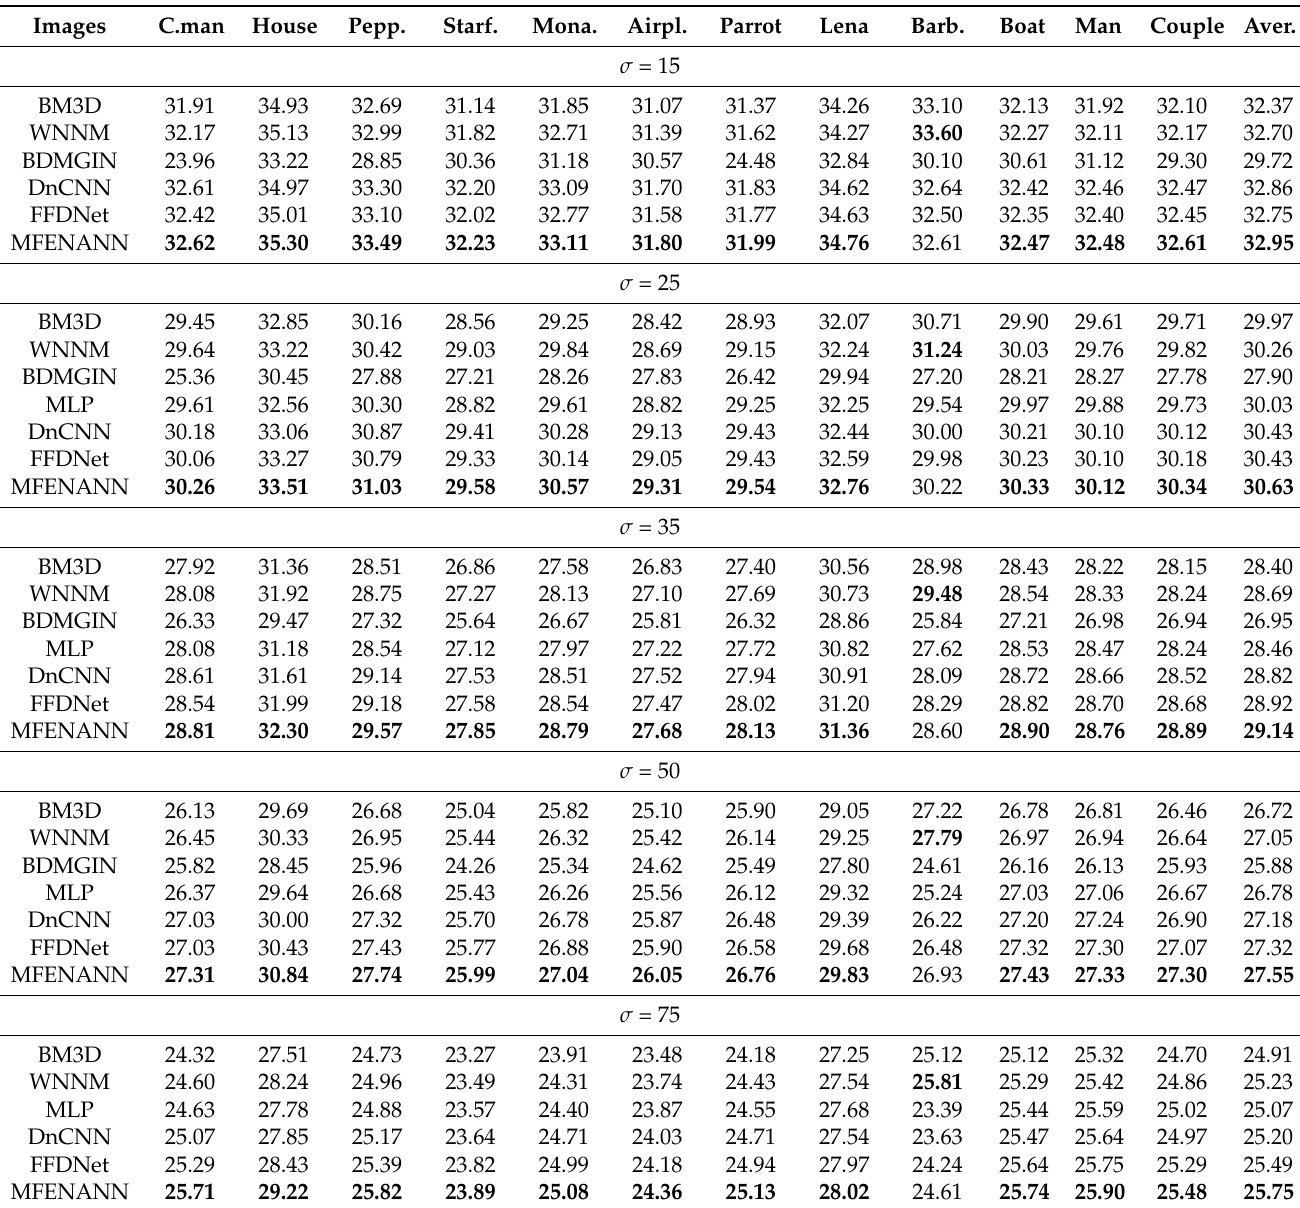
Table 4. The PSNR (dB) values for restored images of “Set12” using several state-of-the-art algorithms at noise levels of 15, 25, 35, 50 and 75. The bold numbers are the largest from the corresponding noise levels. Images